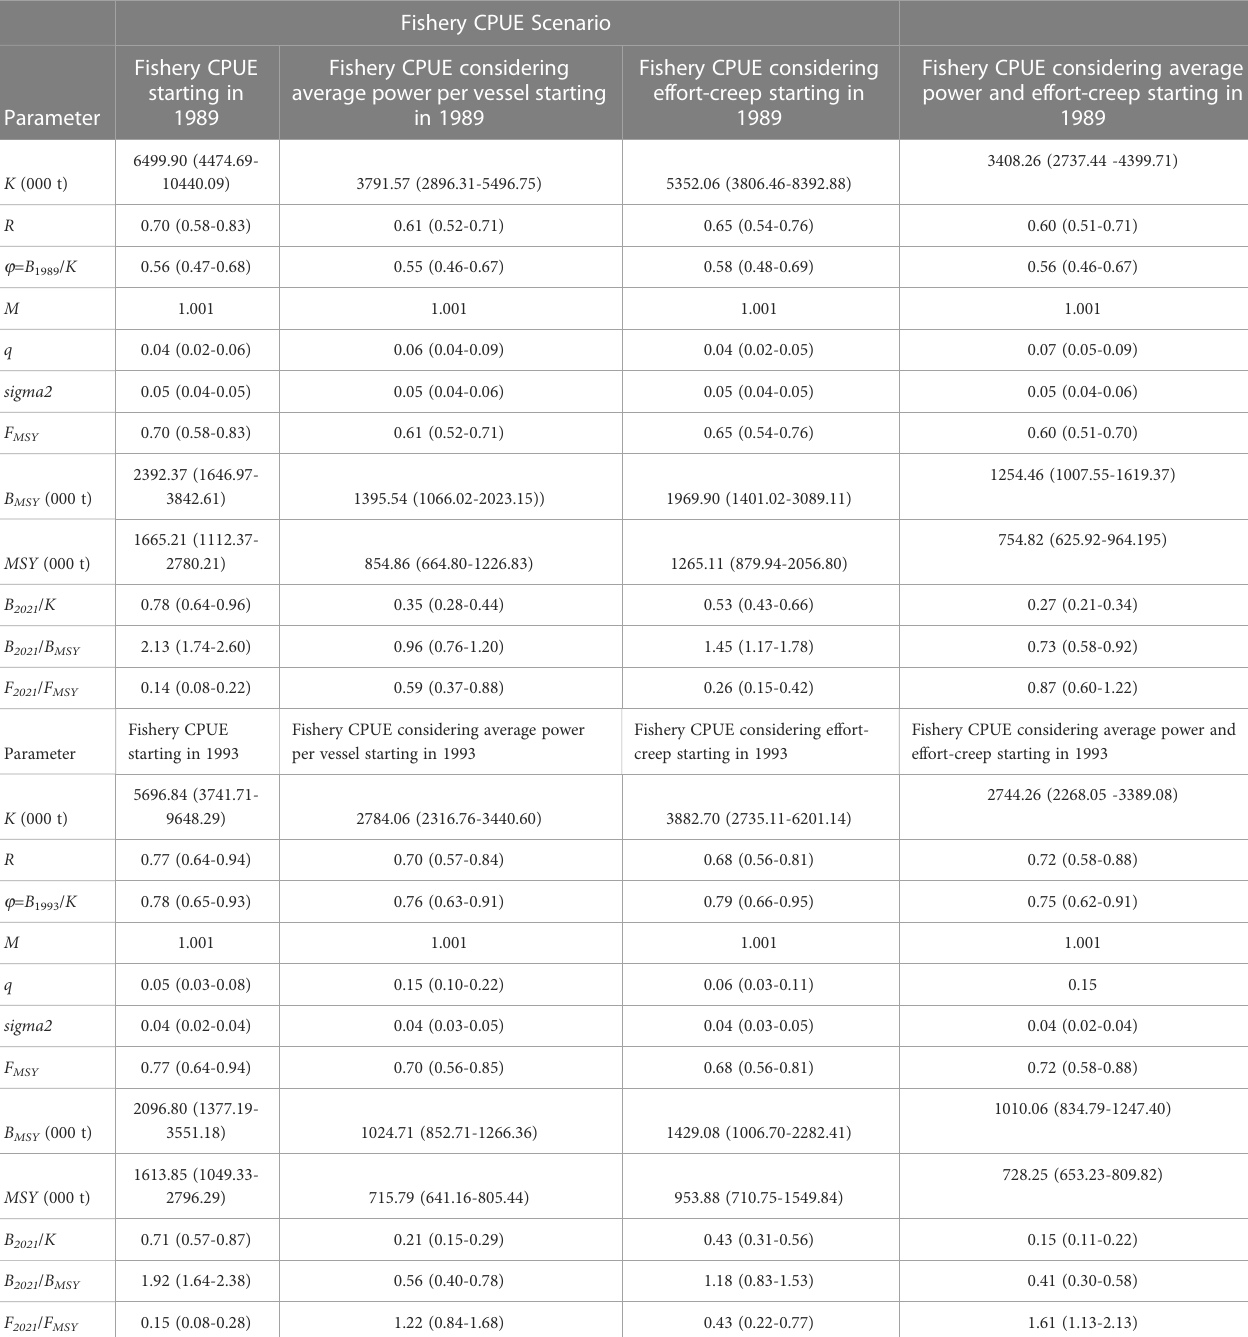
TABLE 2 Summary of parameter estimates and 95% Bayesian credible intervals (showed in parentheses) from the JABBA scenario based on the Small yellow croaker fi shery CPUE index and Schaefer model. Fishery CPUE